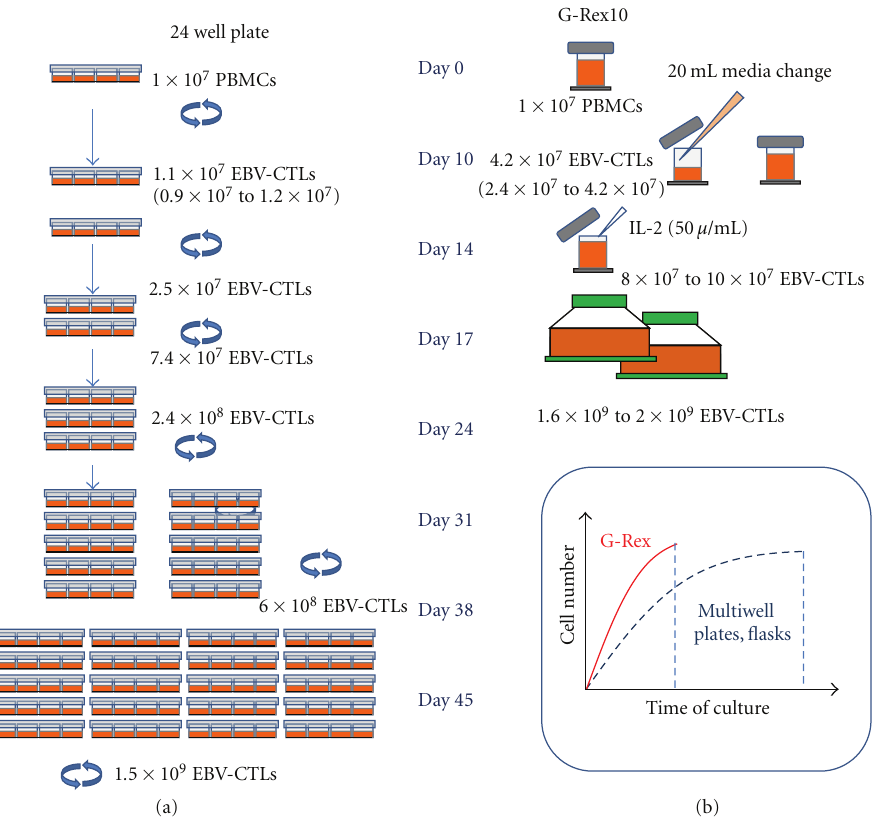
Figure 5: Optimization of antigen-specific CTL manufacture decreases the number of interventions while increasing the cell output. (a) illustrates the level of complexity associated with the generation of antigen-specific CTLs using conventional 24-well plates and the reduced number of interventions required when reproducing the same protocol using the G-Rex. (b) shows how the implementation of the G-Rex device decrease the in vitro culture time when compared with the conventional